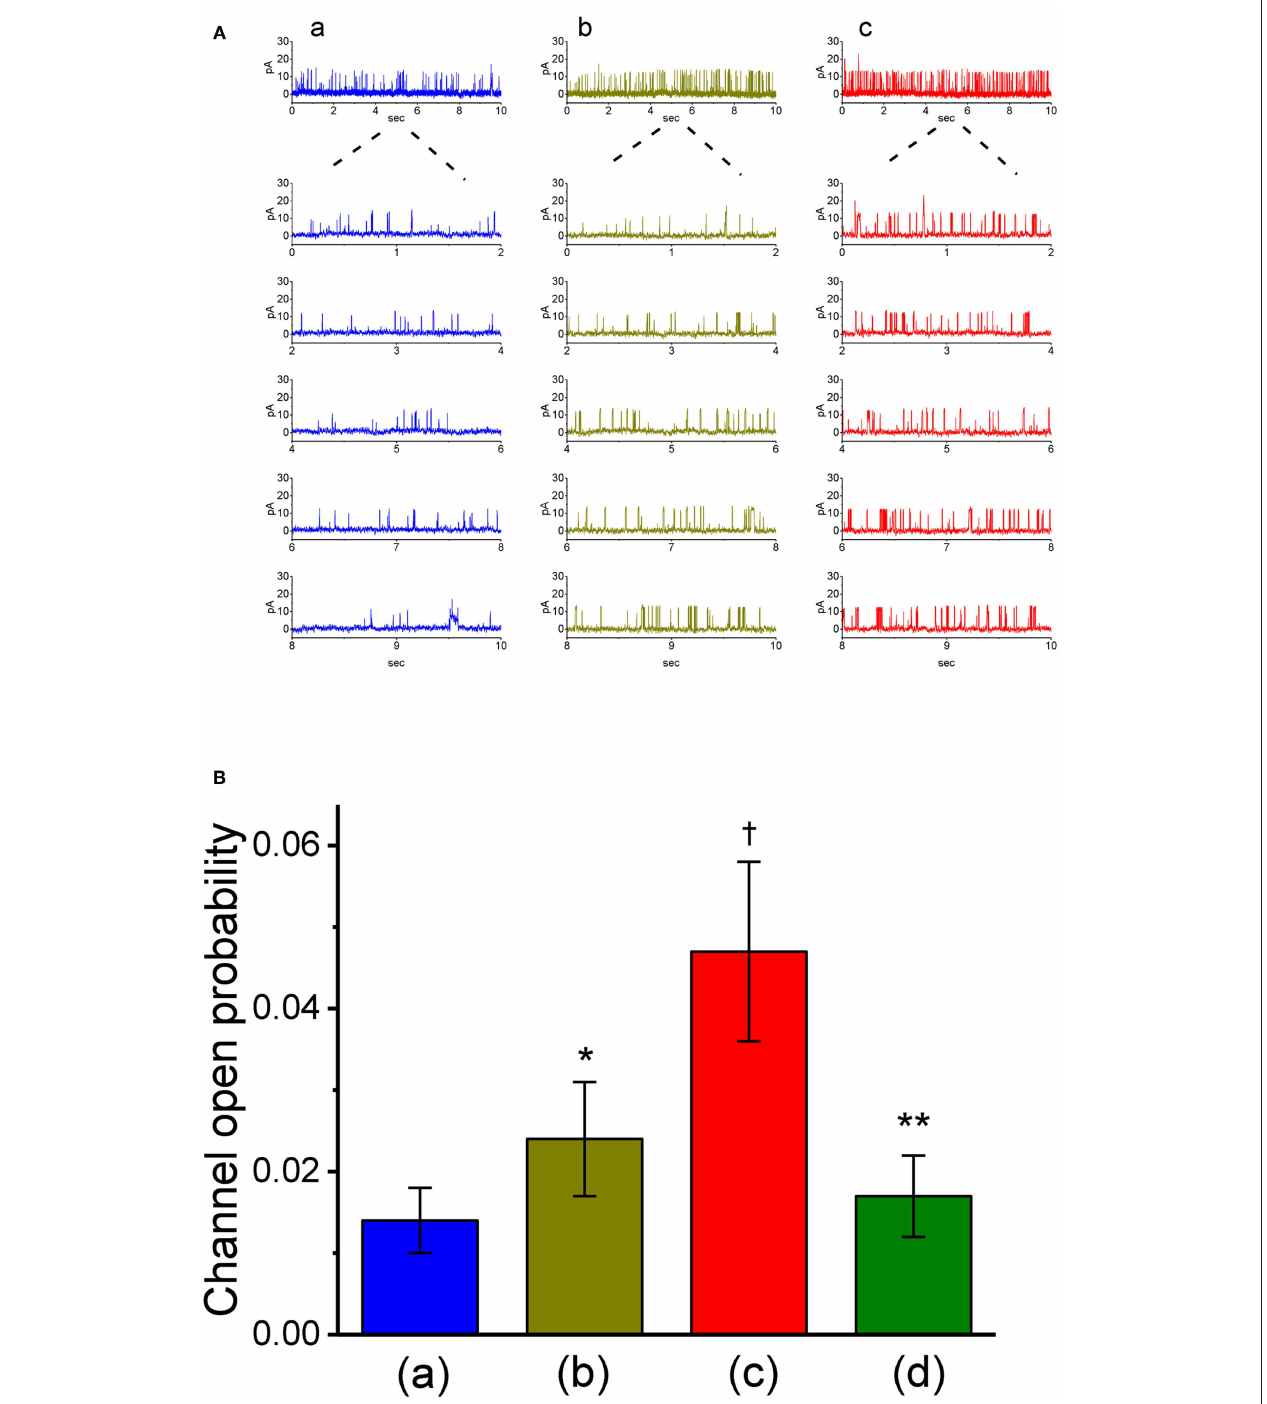
FIGURE 5 | Stimulatory effect of VP on the activity of large-conductance Ca 2 + -activated K + (BK Ca ) channels measured from on-cell patch recordings of GH 3 cells. In these cell-attached current recordings, cells were bathed in normal Tyrode’s solution containing 1.8mM CaCl 2 and channel activity was measured by filling the pipette with K + -containing solution. (A) BK Ca channel activity measured at the holding potential of + 60mV relative to the bath. Panel a is control (i.e., in the absence of light and photosensitizer VP), while panels b and c were obtained in the presence of 3 µ M VP and 3 µ VP plus illumination with a light intensity of 5.5 mW/cm 2 , respectively. The lower parts in each panel indicate the expanded traces recorded from the uppermost part. Note that channel opening causes an upward defection. (B) Summary bar graph showing the effects of VP and VP plus illumination on the probability of BK Ca channels that would be open (mean ± SEM; n = 11–13 for each bar). *Significantly different from control ( P < 0.05), † significantly different from control ( P < 0.01), and **significantly different from VP (3 µ M) plus illumination group ( P < 0.01).